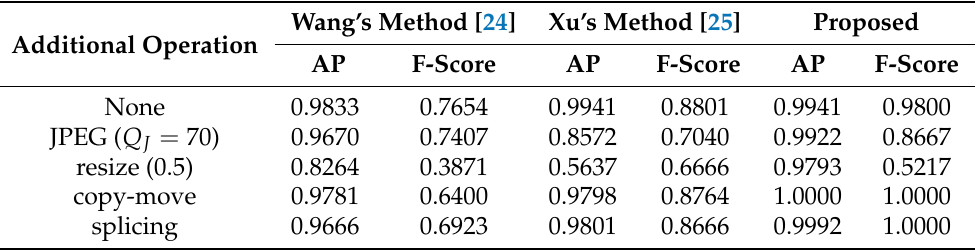
Table 5. Comparison with state-of-the-art method under additional operation (dataset: CycleGAN). Additional Operation